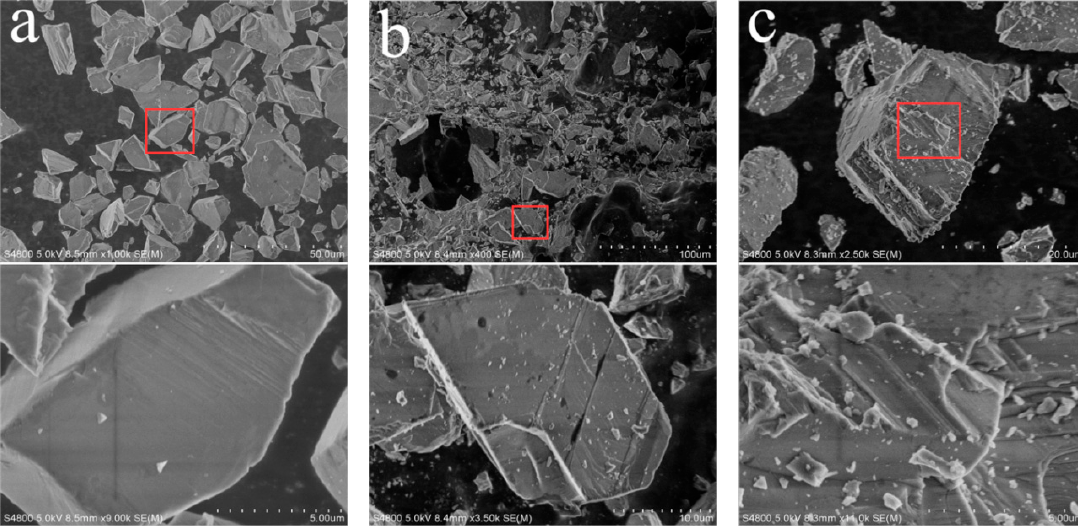
Figure 10. Scanning electron microscope (SEM) images of fluorite particle samples: ( a ) CF; ( b ) GF; and ( c ) PF.